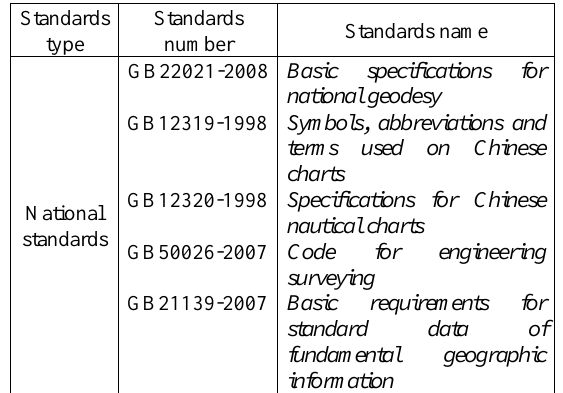
Table 2 . Some basic national standards in "Geographic Information Standard System (2009)".